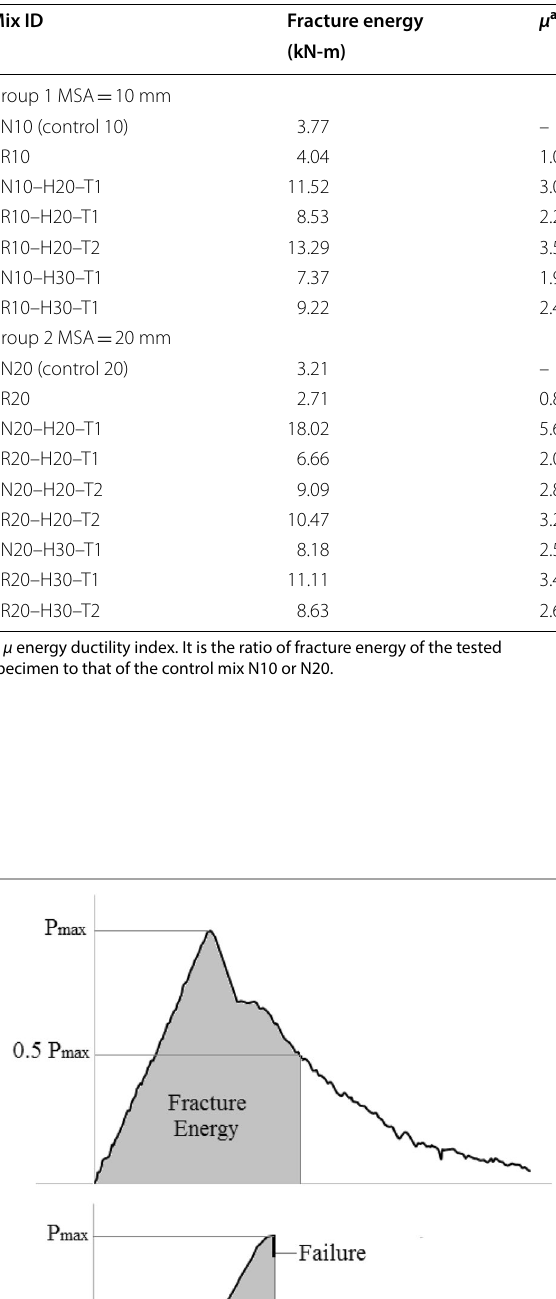
Table 8 Absorptio n values of the tested mixes.